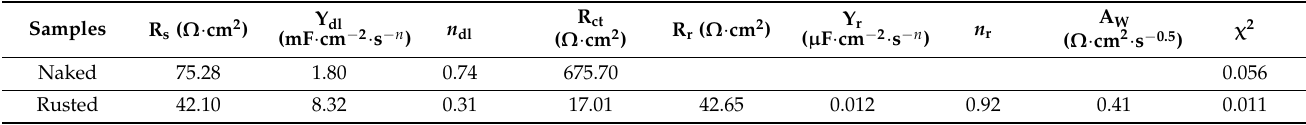
Table 1. Fitting data of impedance parameters in equivalent